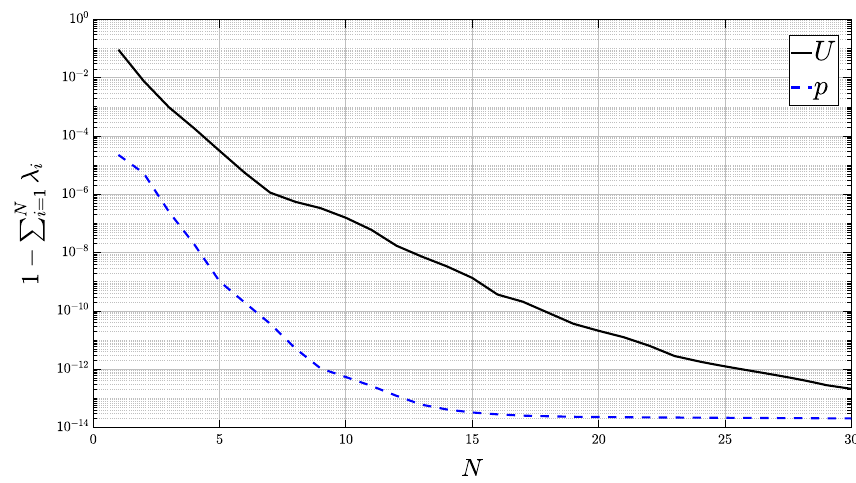
Fig. 2 The cumulative ignored eigenvalues decay for the first numerical case of the flow past a backward step. In this figure, the solid black line refers to the velocity eigenvalues and the dashed blue line corresponds to the pressure eigenvalues